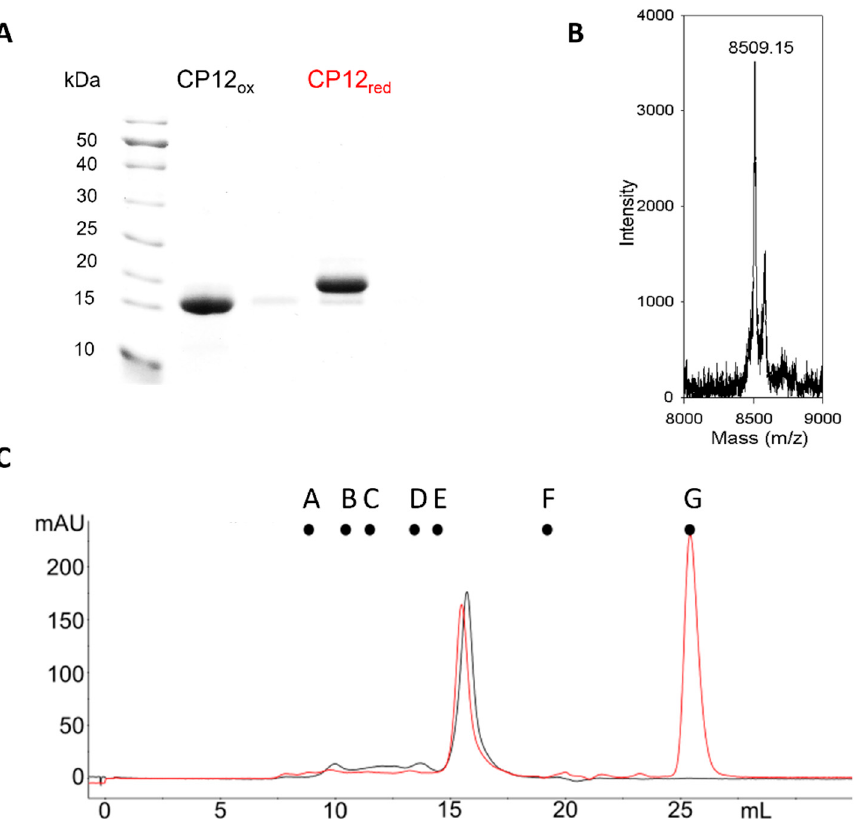
Figure 2. CP12 behaves as an IDP. ( A ) SDS-PAGE (12%) of 4 µ g C. reinhardtii recombinant CP12 under its oxidized or reduced state. ( B ) MALDI-ToF mass spectrum of the native CP12 isolated from the PRK/GAPDH/CP12 complex of C. reinhardtii . ( C ) Size-exclusion chromatography